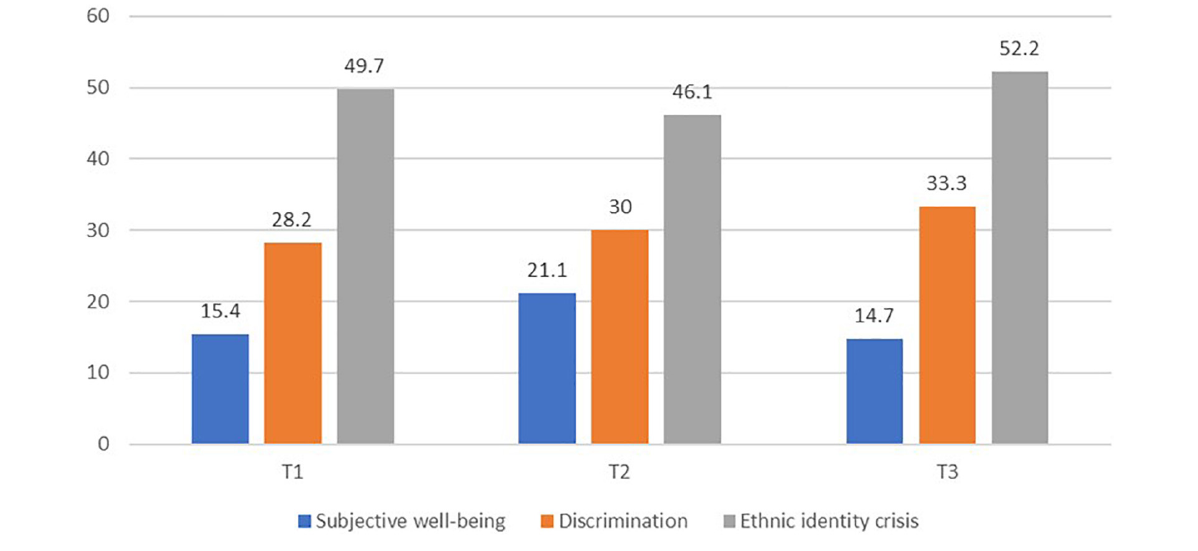
FIGURE 1 | Percentages of low subjective well-being, high discrimination and high ethnic identity crisis across timepoints. Tl–T3 represent data over 3 observations.